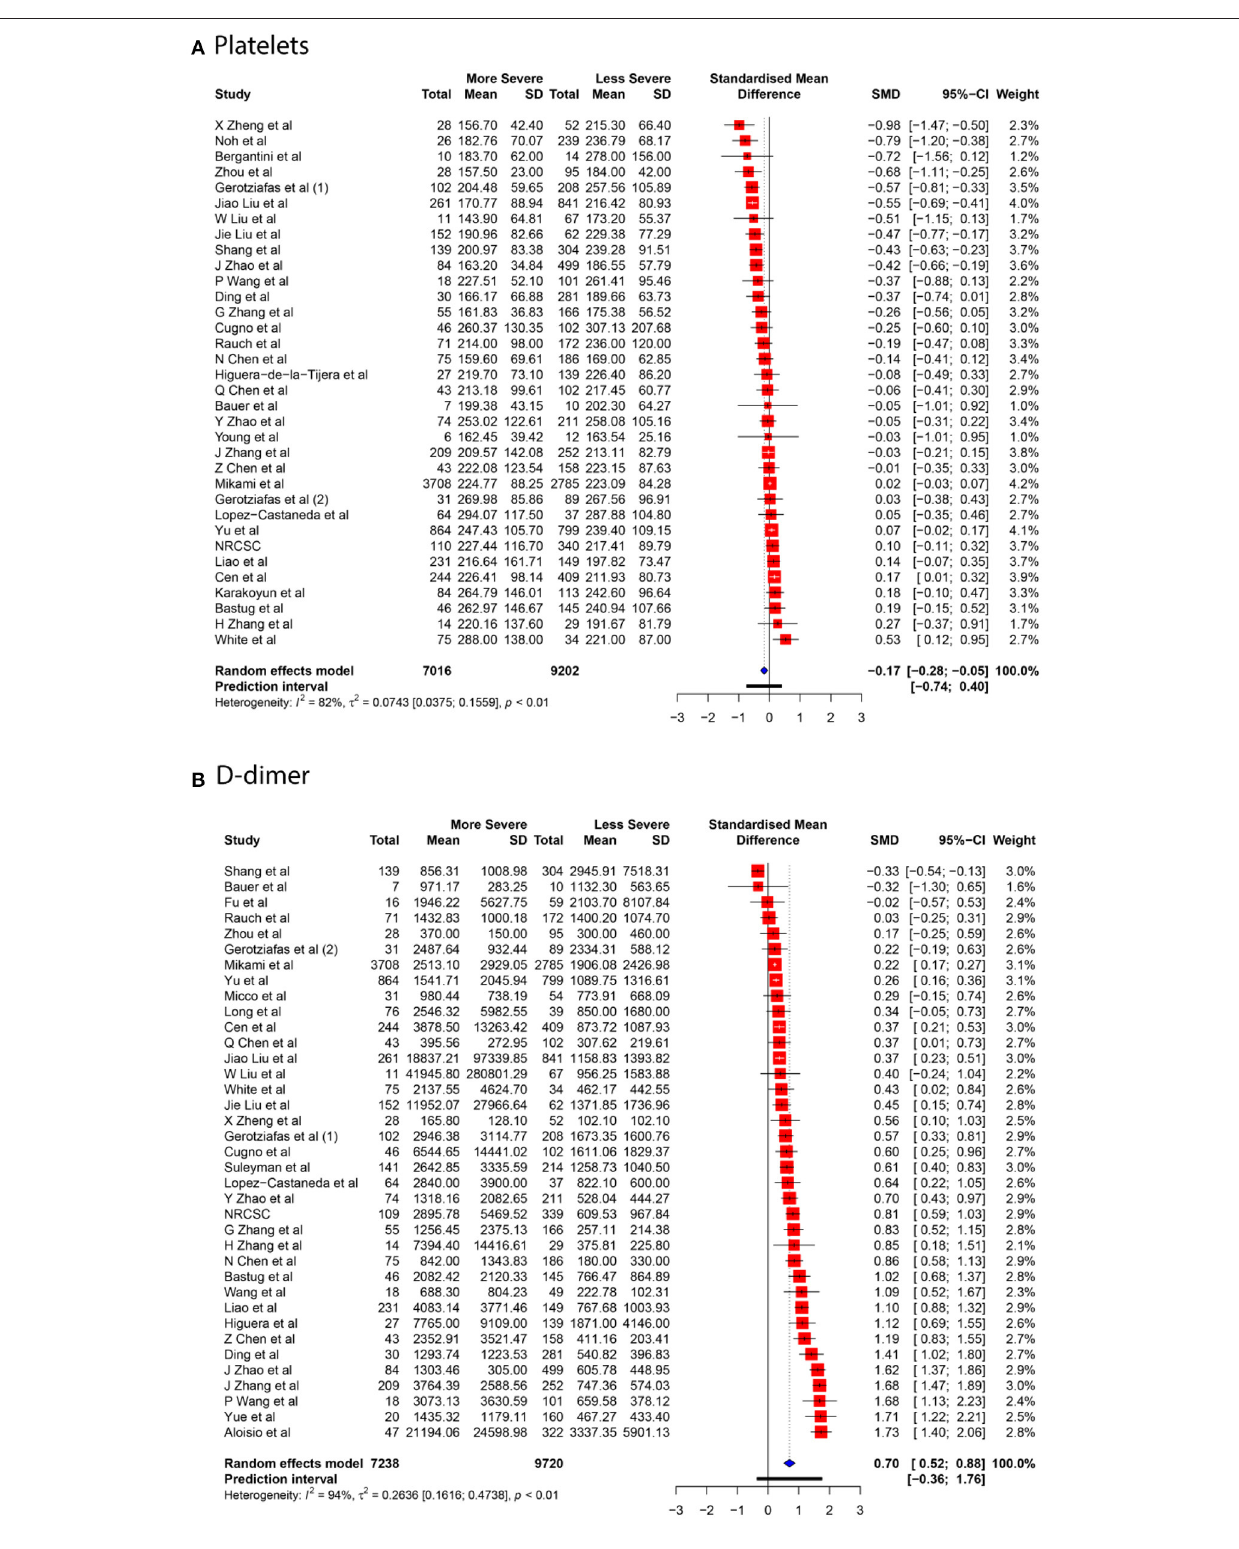
Frontiers in Cardiovascular Medicine |